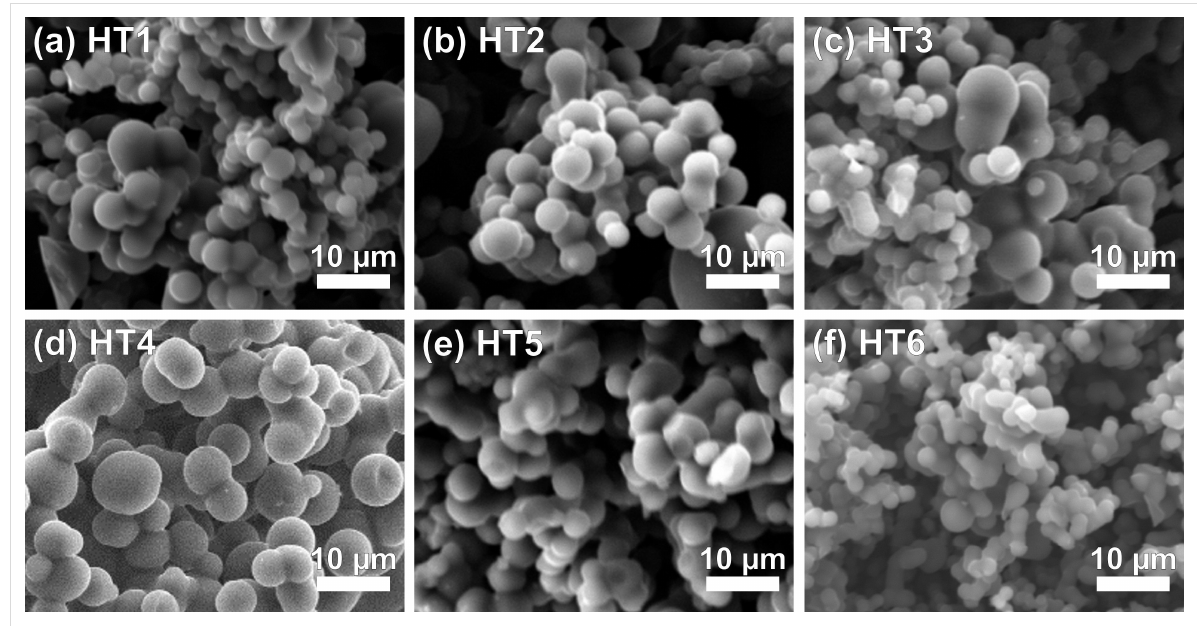
Figure 1: SEM images of HT carbons: a) HT1, b) HT2, c) HT3, d) HT4, e) HT5 and f)